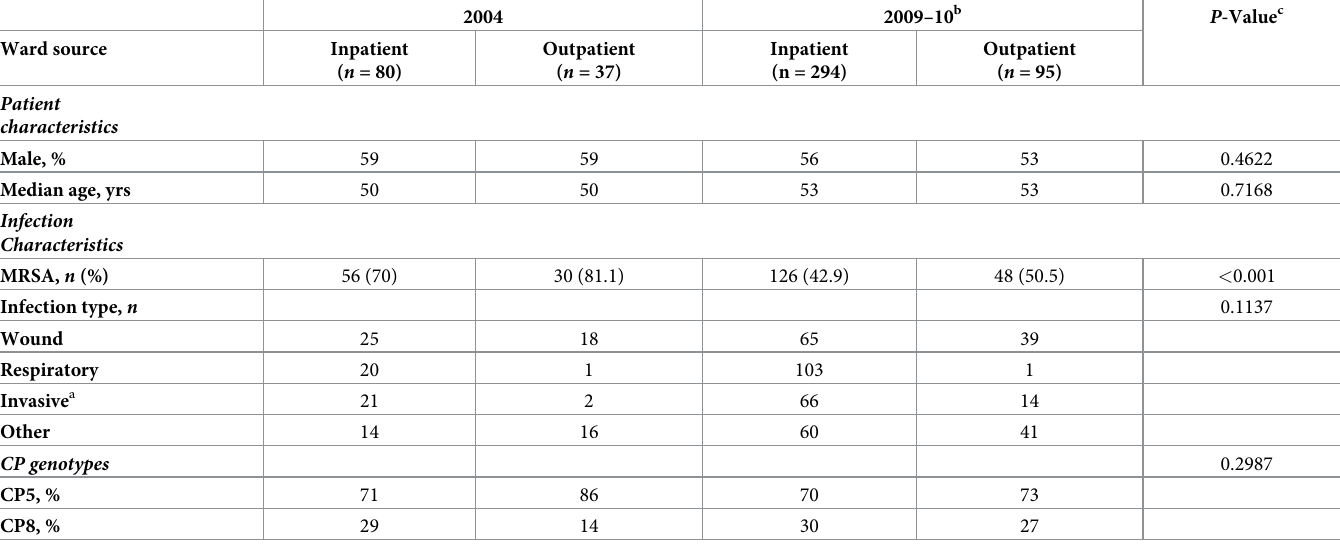
Table 1. Patient demographics and characteristics of S . aureus